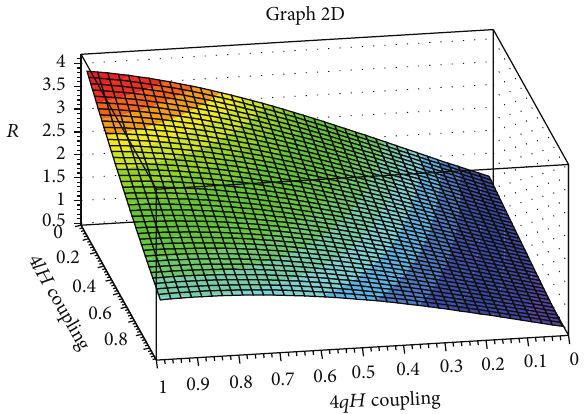
Figure 10: The surface in the space of parameters of the suppression factors 4𝑑𝐻 , 4𝑢𝐻 , and 4𝑙𝐻 in the Higgs coupling to the quarks and leptons of the 4th generation, at which the value of ratio 𝑅 = 1 , corresponding to the Standard model prediction, is